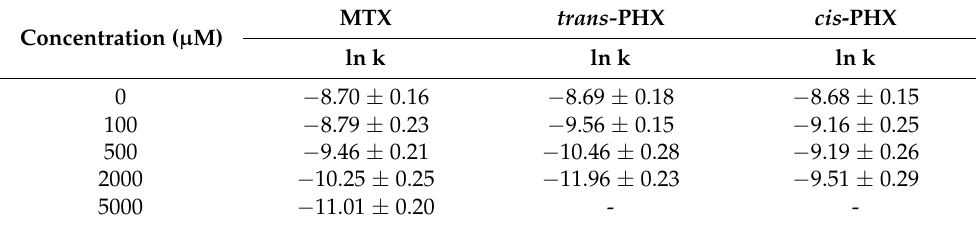
Table 1. The calculated ln k values of the samples investigated.